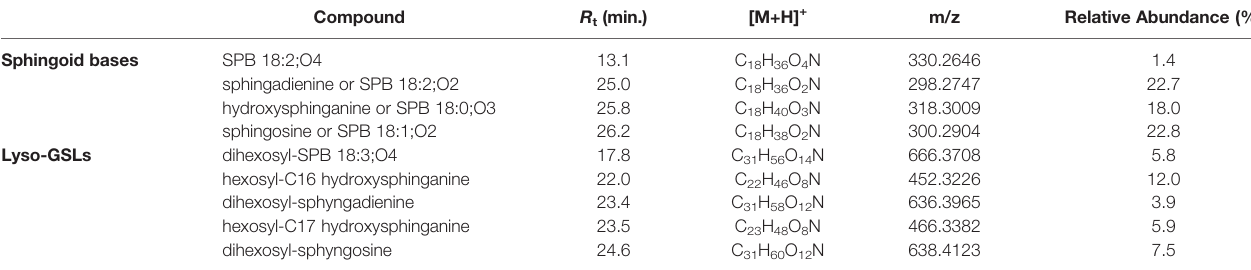
TABLE 4 | Sphingolipids identi fi ed in the organic extract from Botrylloides niger . Compound R t (min.) Relative Abundance (%) Sphingoid